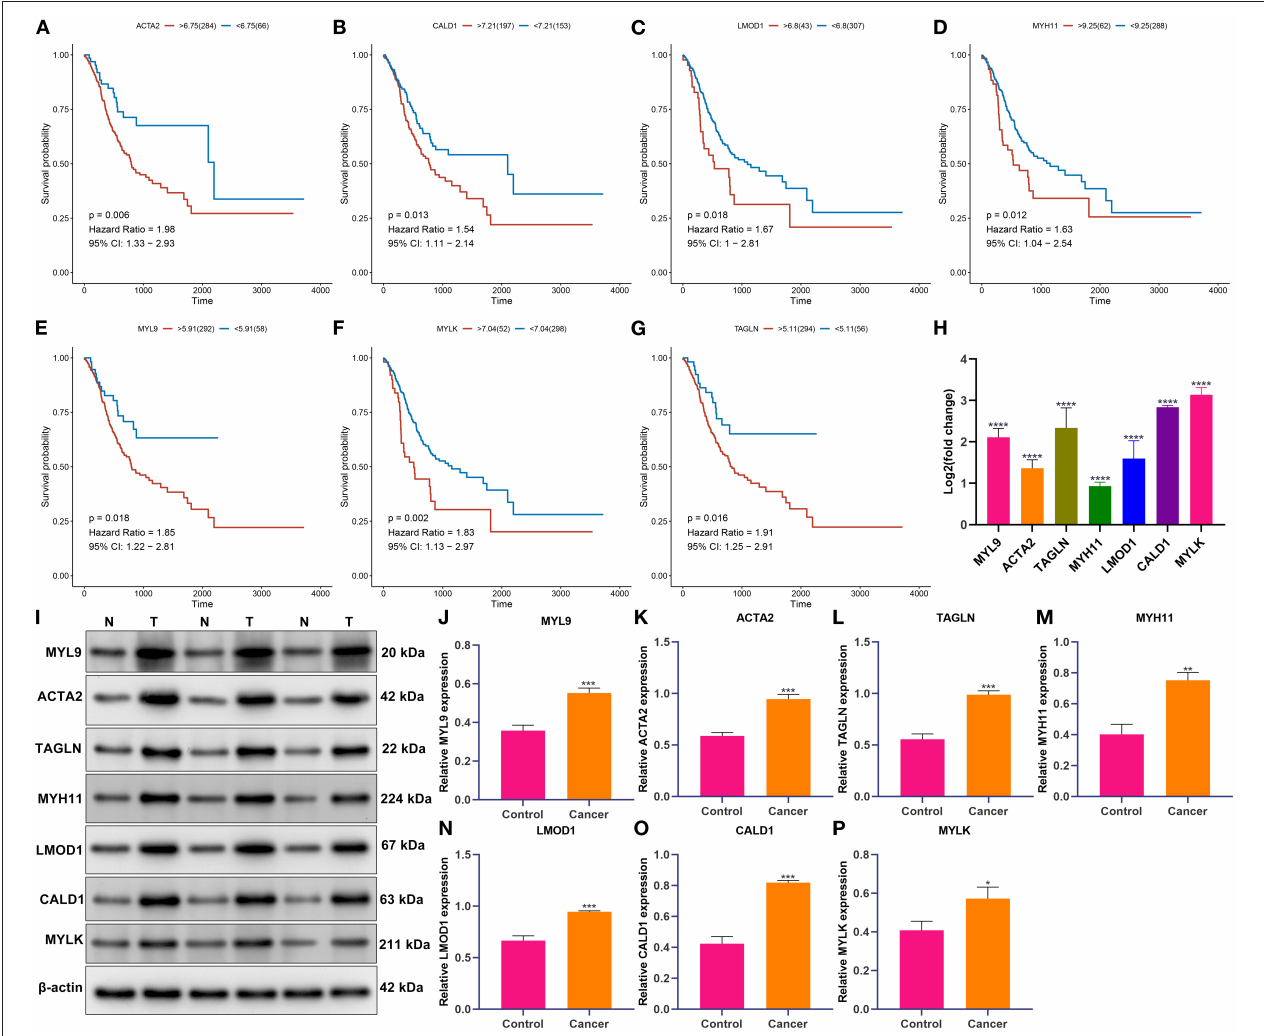
FIGURE 7 | Verification of prognostic implication and deregulated expression of aging molecular phenotype-relevant key genes. (A–G) Kaplan–Meier curves were conducted for the investigation of survival significance of MYL9, ACTA2, TAGLN, MYH11, LMOD1, CALD1, and MYLK across patients with gastric cancer patients. (H) The mRNA expressions of MYL9, ACTA2, TAGLN, MYH11, LMOD1, CALD1, and MYLK were verified in 20 paired tumors and controls with RT-qPCR. The displayed graph contained normalized data to controls. (I–P) Western blotting was conducted for verification of the expressions of MYL9, ACTA2, TAGLN, MYH11, LMOD1, CALD1, and MYLK in tumors and controls. * p < 0.05; ** p < 0.01; *** p < 0.001; **** p <